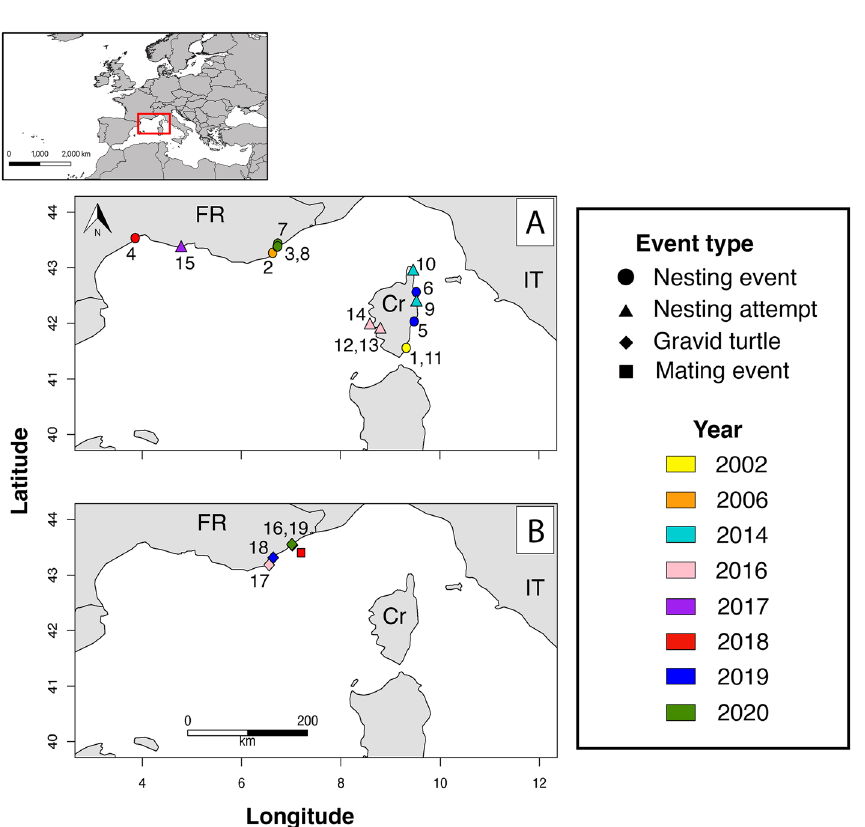
Figure 5. Spatial distribution of ( A ) nesting observations (climbing, attempted and successful nesting) and ( B ) other observations related to reproduction (gravid turtle stranding and mating event) recorded between 2002 and 2020. The inset map represents the location of the study area. Numbers refer to events listed in Tables 1 and 2. FR continental France, Cr Corsica, IT